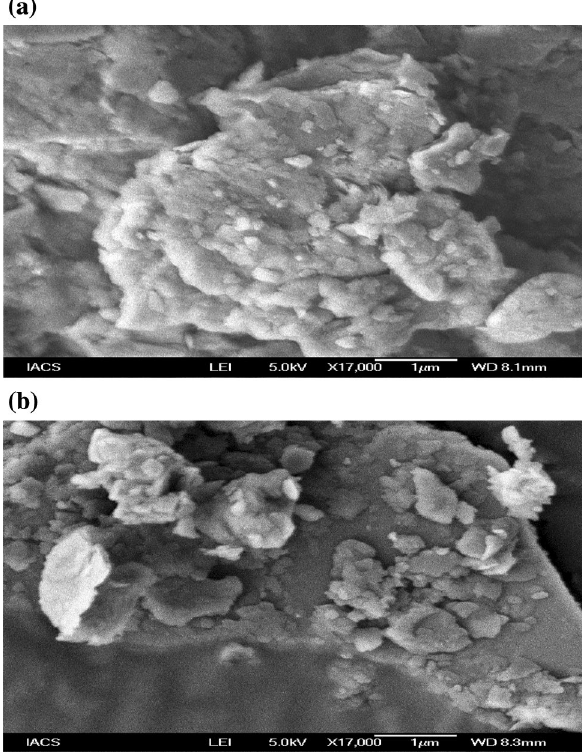
Fig. 2 a SEM image of native cyanobacterial consortium and b SEM image of chromium-loaded cyanobacterial